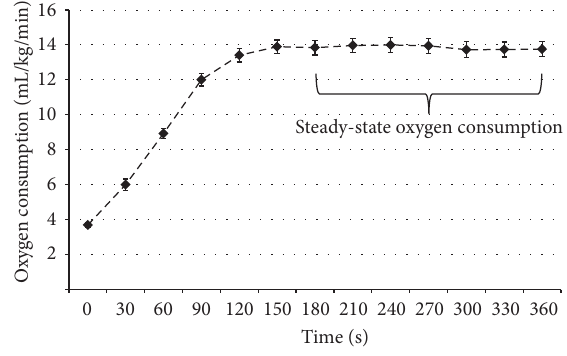
Figure 1: Oxygen consumption over a six-minute walk test in 82 persons with multiple sclerosis. VO 2 = oxygen consumption